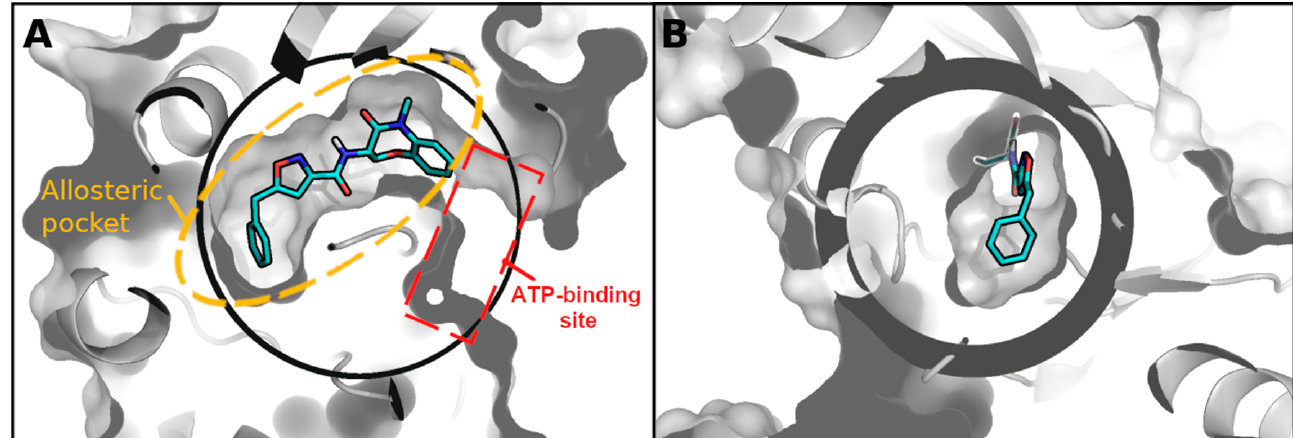
Figure 2. Binding sphere surrounding the binding pocket in 5HX6 (X-ray ligand indicated in cyan). Figure was produced using PyMOL and the sphere was calculated using the center and radius used in GOLD for all docking calculations. ( A ) Side view of the allosteric back pocket. The docking sphere also includes a portion of the ATP-binding site which begins immediately after the point where the ligand ends. ( B ) Bottom-up view of the allosteric back pocket.